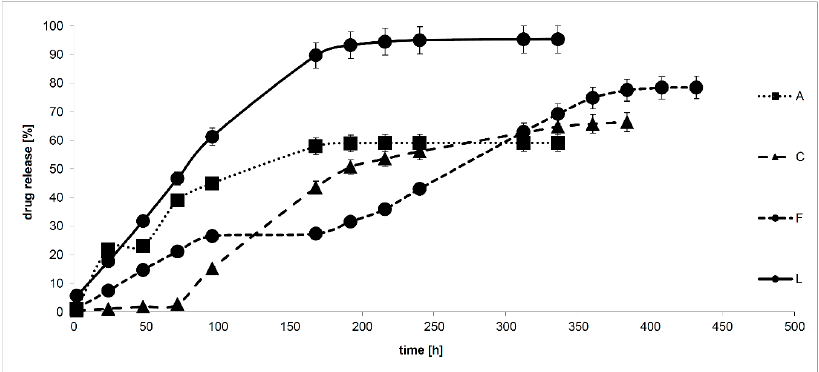
Figure 2. 5 (cid:31) fluorouracil (5-FU) release profile from the CL-PEG-HDI and rac -LA-PEG-HDI hydro- Figure 2. 5-fluorouracil (5-FU) release profile from the CL-PEG-HDI and rac -LA-PEG-HDI gels. HDI: hexamethylene diisocyanate.